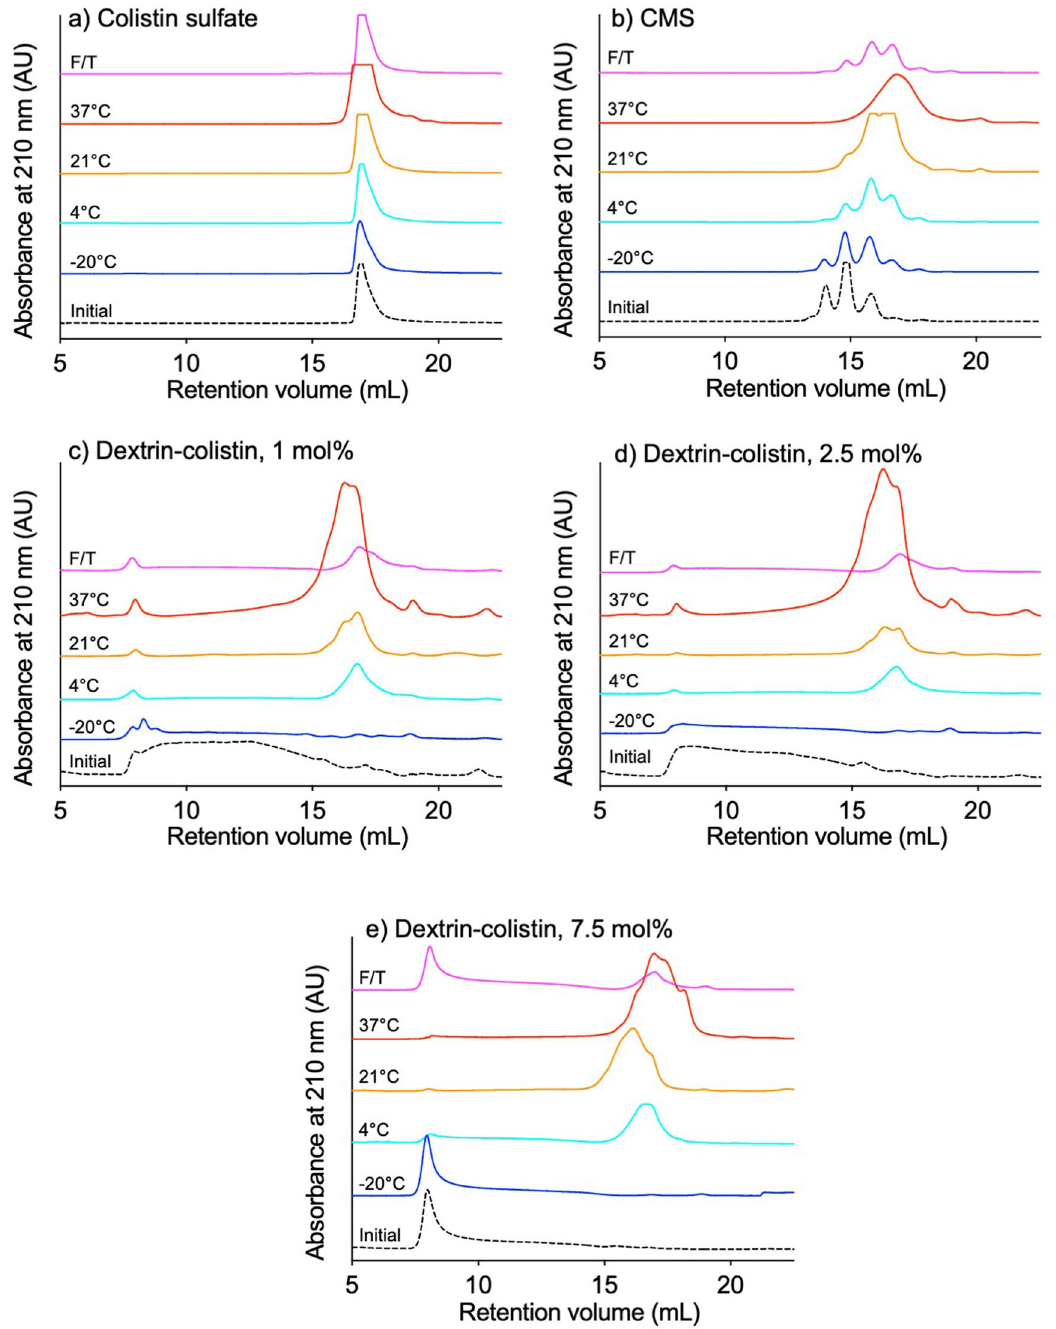
Figure 3. FPLC chromatograms showing absorbance at 210 nm of ( a ) colistin sulfate, ( b ) colistimethate sodium (CMS) and dextrin–colistin conjugates with ( c ) 1 mol%, ( d ) 2.5 mol% and ( e ) 7.5 mol% succinoylation before (dotted line) and following storage at − 20 (dark blue line), 4 (light blue line), 21 (yellow line) or 37 (red line)°C for 12 months or exposed to weekly freeze-thawing for 5 weeks (pink